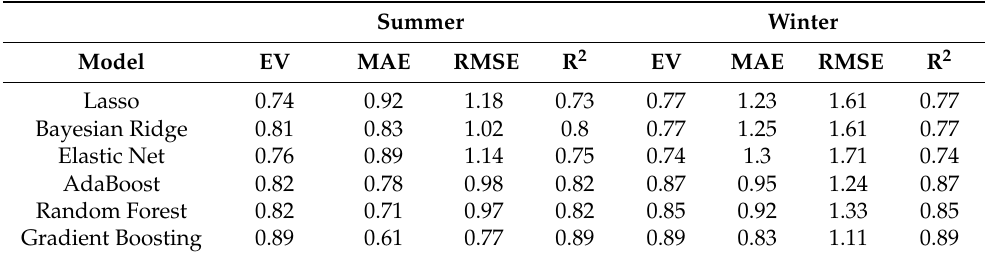
Table 3. Predictive performance of the models on summer and winter